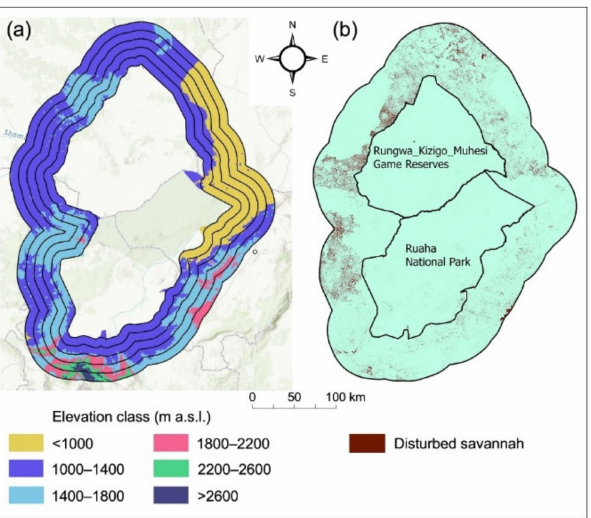
Figure 9. ( a ) Elevation map of the surroundings of the PA based on SRTM DEM and ( b ) vegetation disturbance occurrence in the area surrounding the